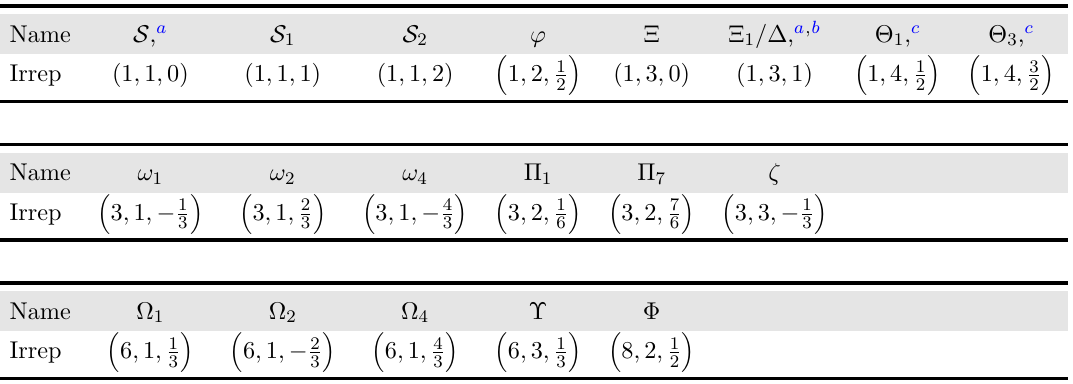
Table 1 . Scalar “exits”: scalar bosons that can couple to a pair of standard model